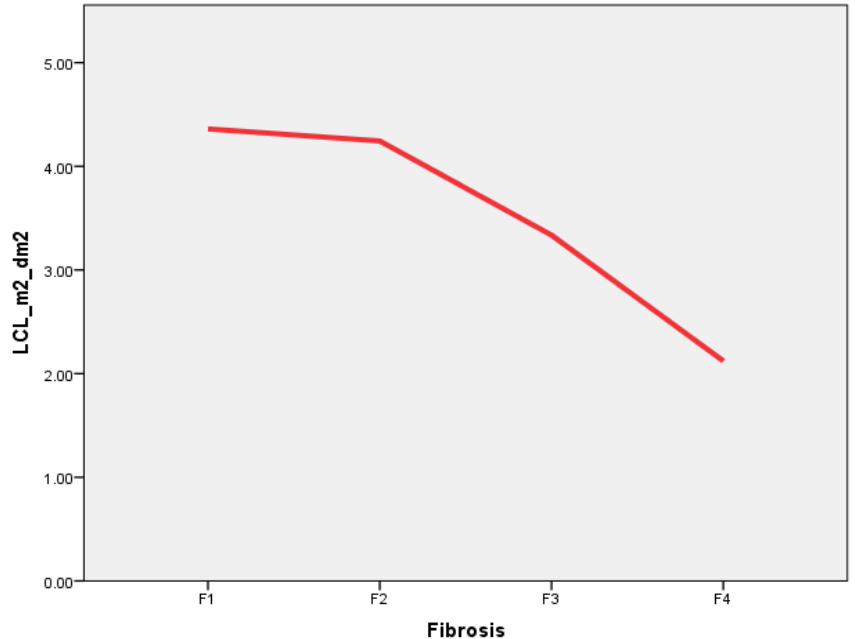
Figure 8. Liver clearance (LCL) relation to increasing liver fibrosis stage. Direct negative association between liver clearance (measured in %/min/m 2 /dm 2 ), and liver fibrosis stage measured according to METAVIR is present. LCL_m 2 _dm 2 —liver clearance measured in right liver lobe and corrected with BSA and LA; Fibrosis—liver fibrosis evaluated in liver biopsy specimen according to META ‐ VIR.